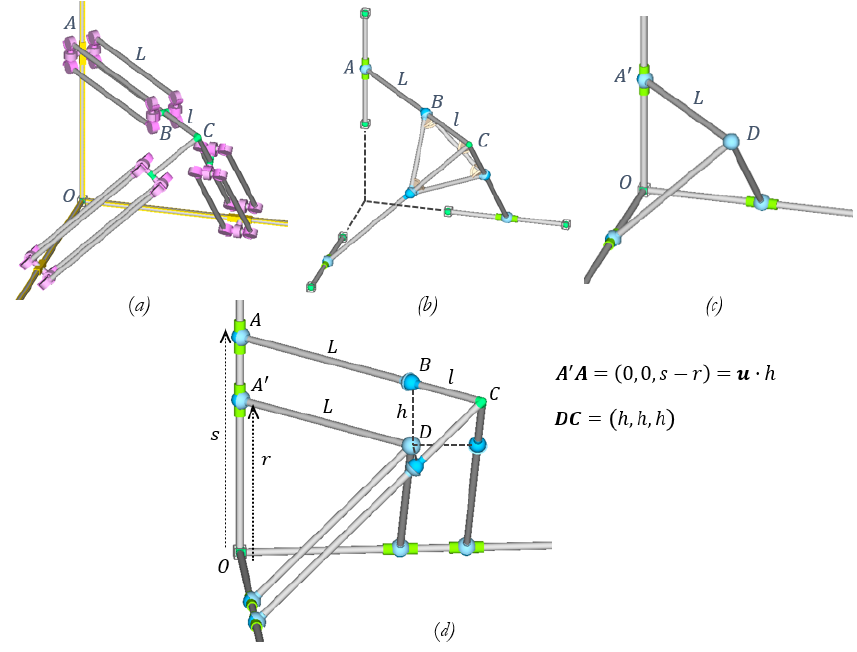
Figure 7. Equivalent simplified manipulator.